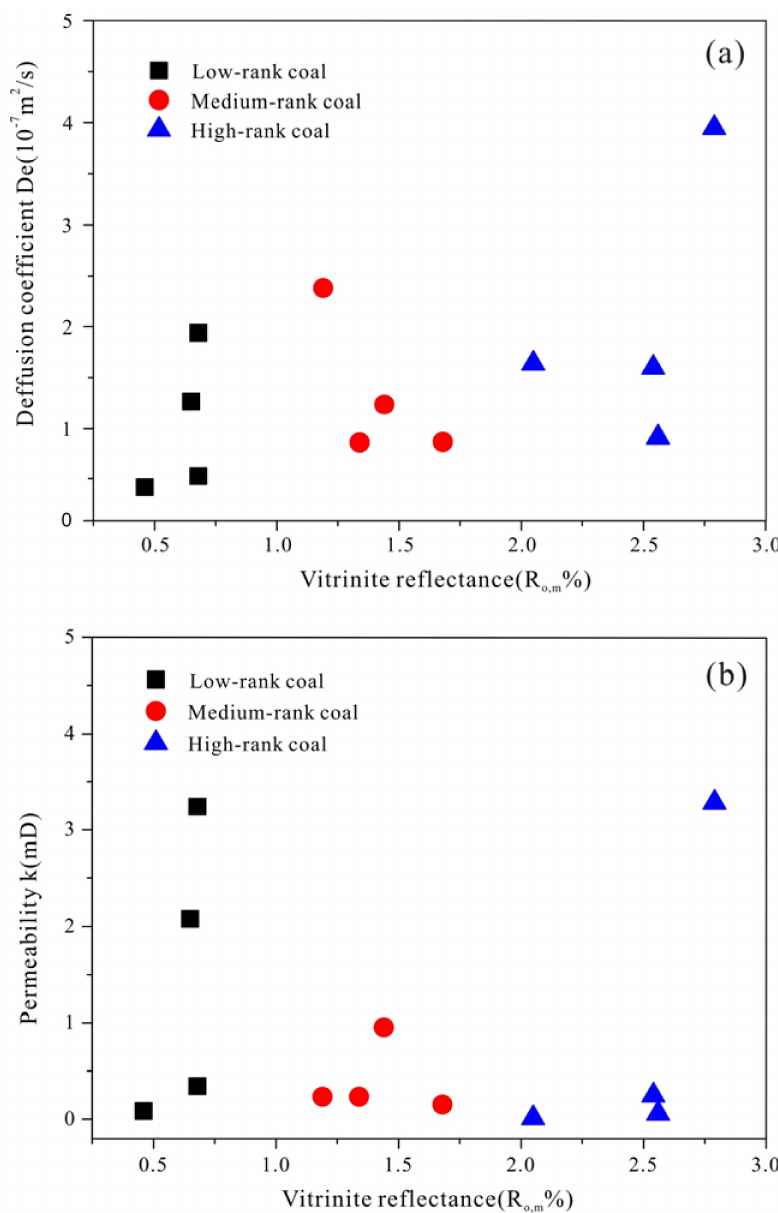
Figure 5. Diffusion coefficient and permeability for the low, medium and high rank coals. ( a ) Diffusion coefficient for the low, medium and high rank coals; ( b ) Permeability for the low, medium and high rank